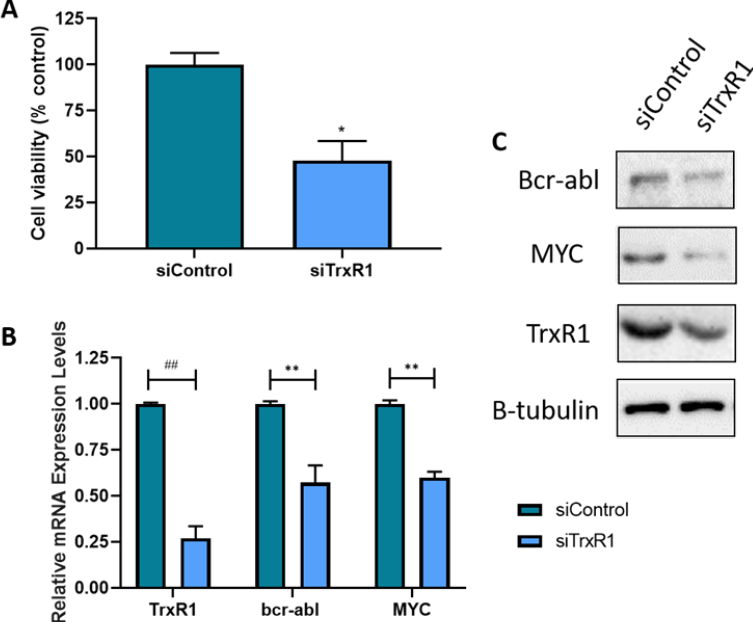
Figure 4. TrxR1 Knockdown Reduces Bcr-abl and c-myc mRNA and Protein Expression. K562 cells were transfected with TrxR1 specific siRNA and a scrambled siRNA control. A : Cell viability was then measured after 24 h. B : RT-qPCR was performed 24 h after transfection to measure the mRNA expression levels of TrxR1, bcr-abl and MYC. RPL32 was used as a normaliser C : Western blotting was performed 48 h after transfection and was used to measure the protein levels of TrxR1, bcr-abl and MYC. B-tubulin was used as a loading control for western blots. A representative of 3 blots is shown. RT-qPCR and cell viability results were analysed with multiple T -tests. Statistical tests compared results of the TrxR1 knocked down cells and the scrambled siRNA control. * = p < 0.05, ** = p < 0.01, ## = p < 0.0001. N = 3. Values displayed as mean ± SEM.